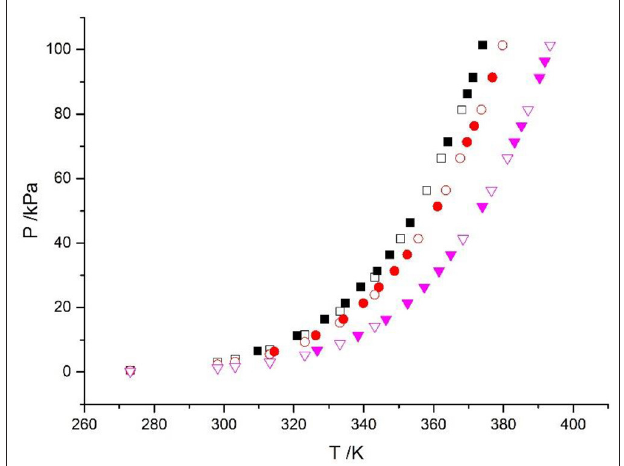
FIGURE 2 | Vapor-liquid equilibrium in the CaCl 2 + H 2 O system. Empty symbols ( , m = 1 mol/kg; , m = 3 mol/kg; , m = 6 mol/kg): literature data ( Xu et al., 2014, 2016; Lan et al., 2017); full symbols ( , m = 1 mol/kg; , m = 3 mol/kg; , m = 6 mol/kg): experimental data (Xu et al., 2014).